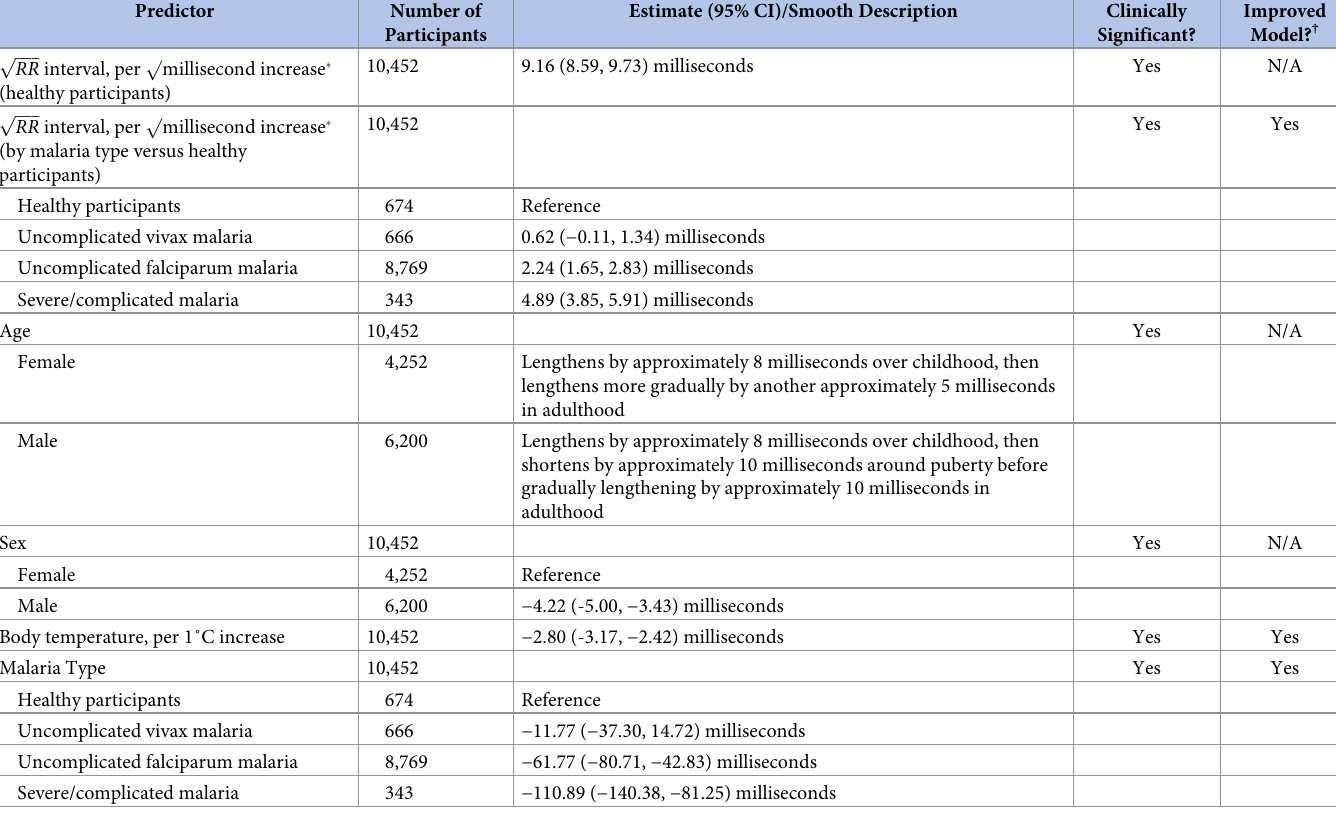
Table 2. Factors affecting the QT interval in